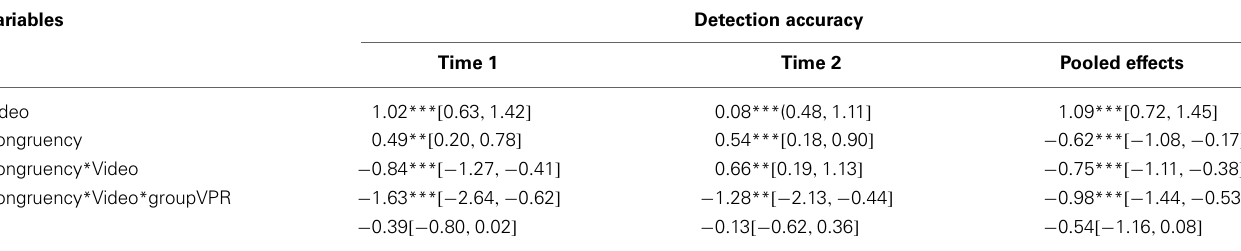
Table 5 | The significant effects of video, congruency and group on detection accuracy and Confidence intervals (T1, T2 and pooled effects).